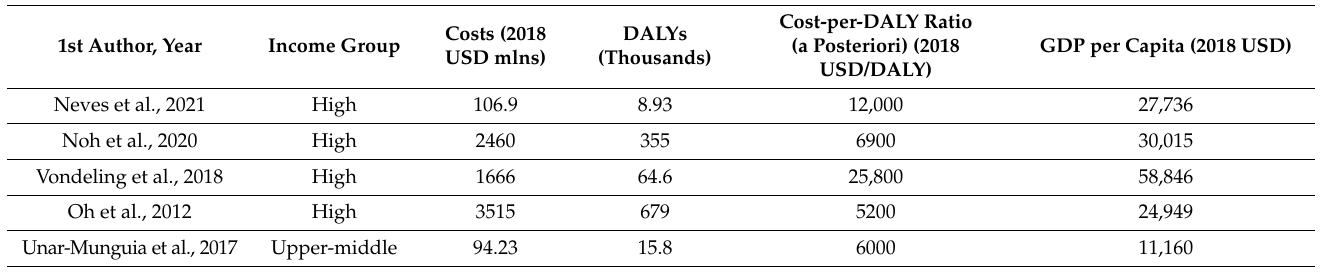
Table 3. Outcomes of included studies. (a) For studies separately performing economic analyses related to costs and DALYs, relevant figures are reported for both measures of the burden (first two columns): the cost-per-DALY ratio was computed (third column), and the table also reports the GDP per capita of the corresponding countries, as retrieved by the World Bank Data (last column). (b) For the remaining studies, assumed cost-per-DALY ratios were retrieved from the studies, along with DALY and derived cost estimates. All data were reported after discounting to 2018